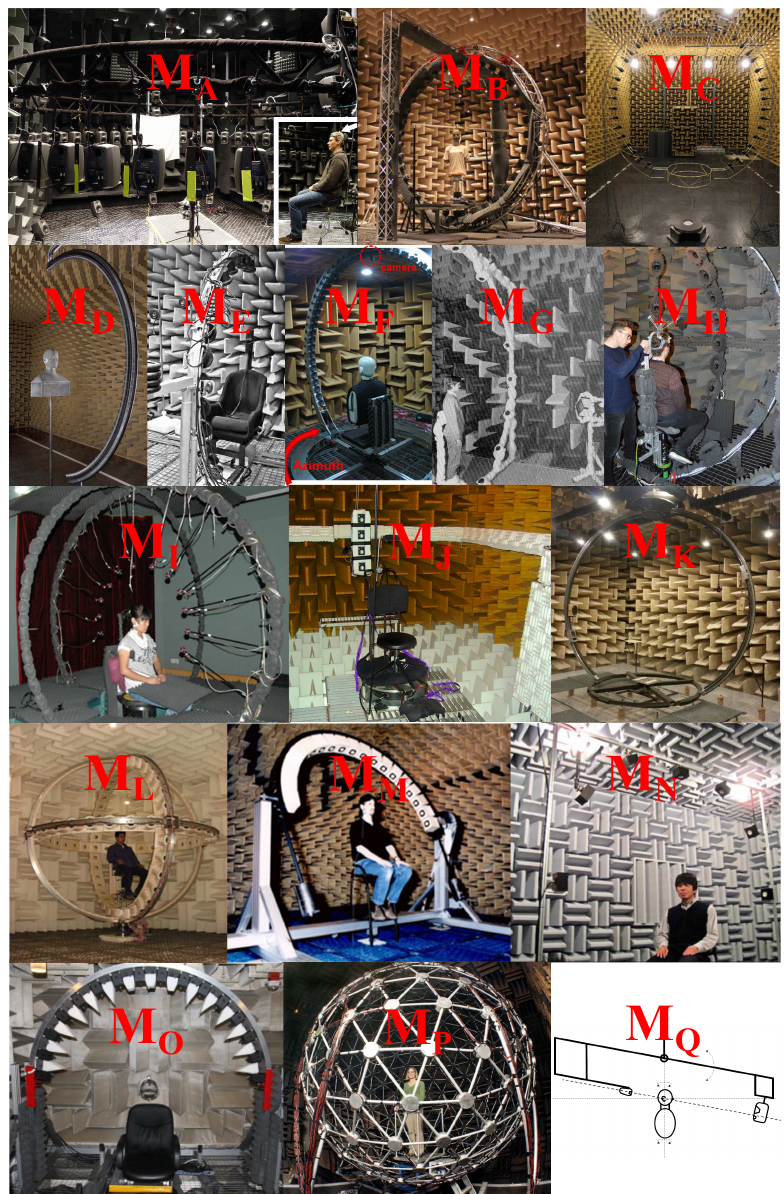
Figure 8. Examples of multi-loudspeaker-based HRTF measurement setups taken from [2,108,116,121–134] (All pictures are taken from available publications, some of them are partly cropped to fit into the overall